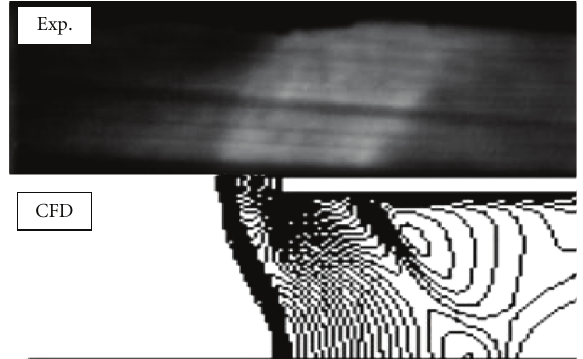
Figure 12: Comparison Exp. and CFD result (HTPB slab @ AOA = 0 ◦ ).